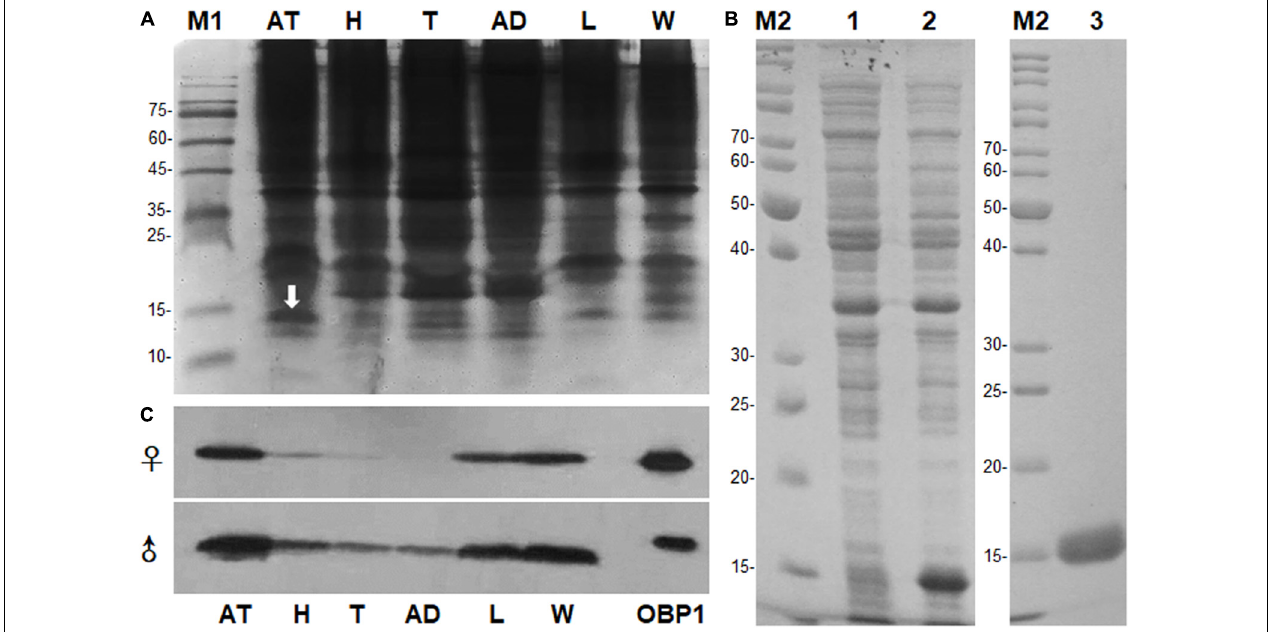
FIGURE 1 | Sex- and tissue-expression profile of MaltOBP1. (A) Electrophoretic analysis of soluble proteins from Monochamus alternatus under 15% native PAGE. M1: Protein molecular weight marker. (B) Recombinant protein analyzed by SDS-PAGE. M2: Protein molecular weight marker; Lane 1: Non-induced pET32a-MaltOBP1 in Escherichia coli ; Lane 2: Expressed protein pET32a-MaltOBP1-His after induction by IPTG; Lane 3: pET32a-MaltOBP1 protein purified through Ni-NTA column; (C) Western blot analysis of MaltOBP1 expression in total protein extracts of male and female adults of M. alternatus . AT, antennae; H, head; T, thorax; AD, abdomen; L, leg; W, wing; OBP1, Recombinant MaltOBP1.